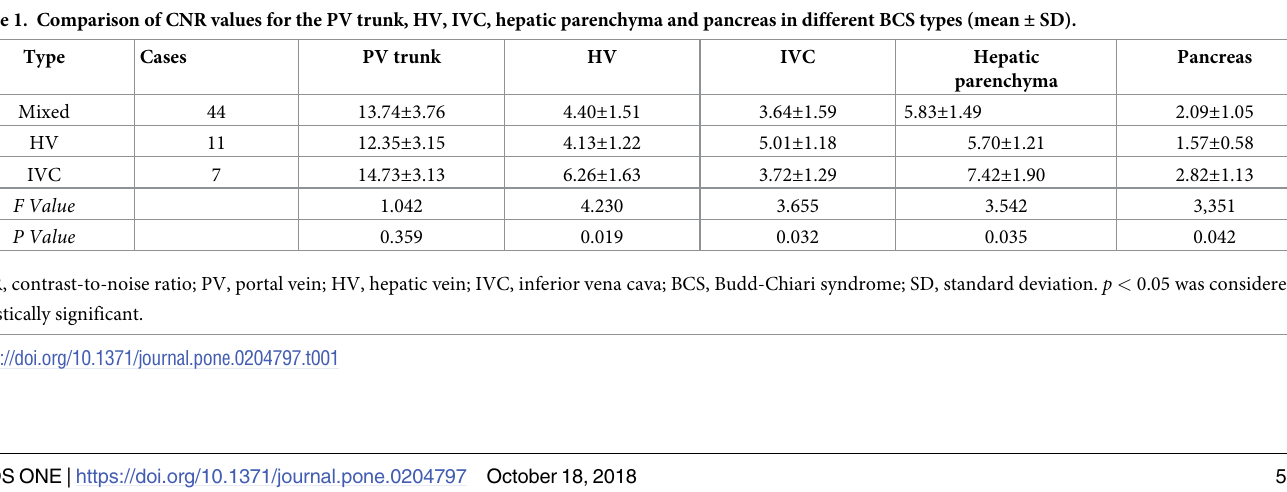
CNR values of the PV trunk, HV, hepatic parenchyma and pancreas in the IVC type were sig- nificantly higher than those in the mixed type and HV type, and with the exception of the PV